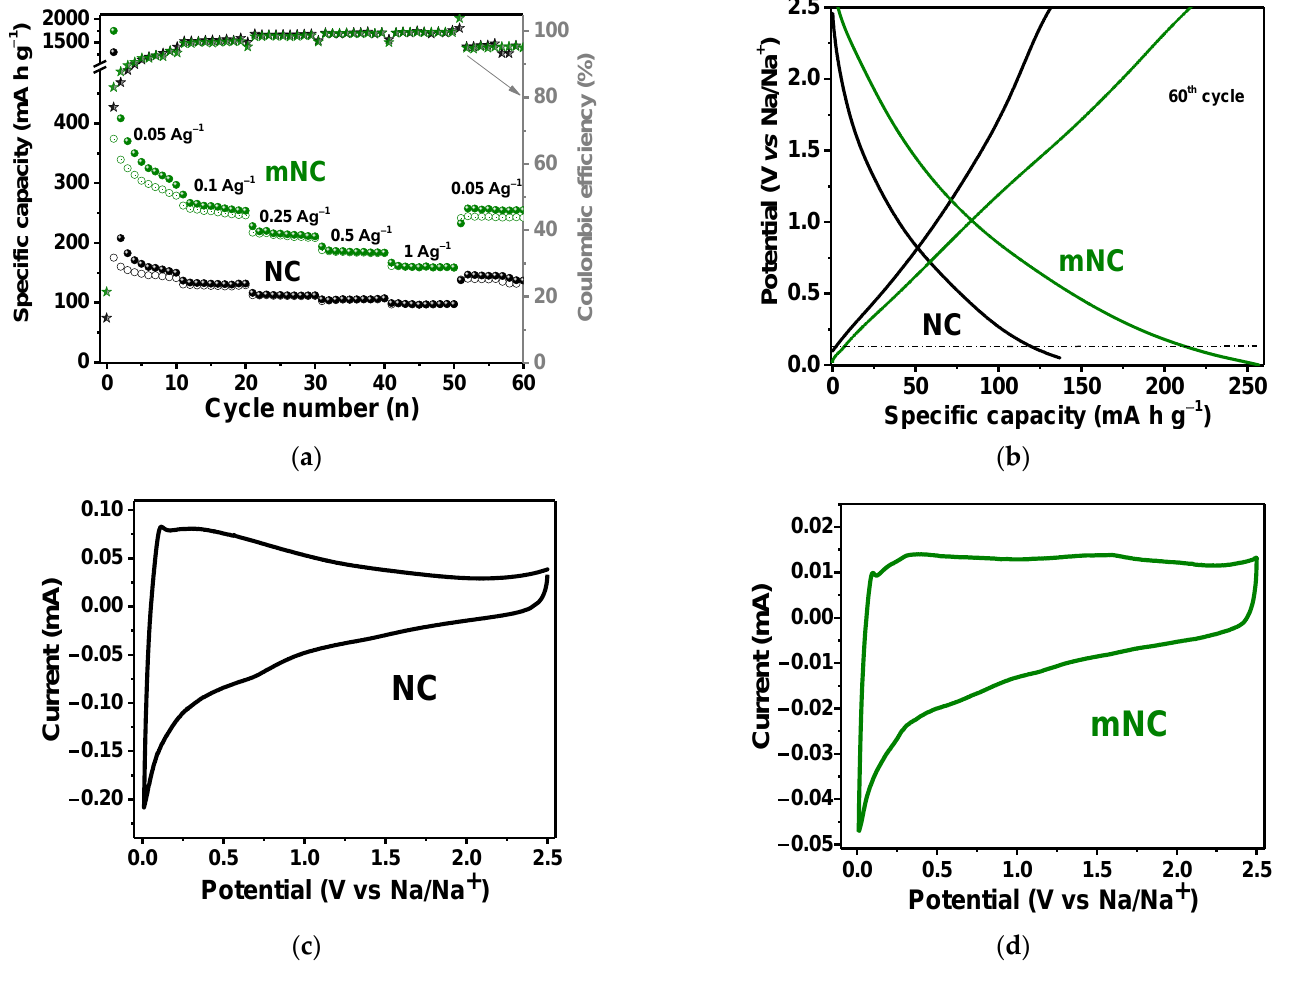
Figure 4. Electrochemical performance of NC and mNC in sodium-ion batteries: ( a ) rate capability at current densities of 0.05 – 1.00 A g −1 ; ( b ) discharge – charge curves at 60th cycles at 0.05 A g −1 ; CV at current densities of 0.05–1.00 A g − 1 ; ( b ) discharge–charge curves at 60th cycles at 0.05 A g − 1 ; CV curves measured at 0.1 mV s − 1 for ( c ) NC and ( d ) mNC. curves measured at 0.1 mV s − 1 for ( c ) NC and ( d )